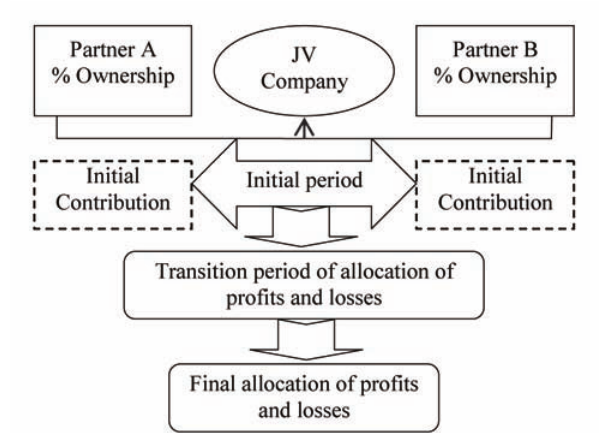
Fig. 1. The process of compensation and allocation of profit and losses in joint ventures (Juan et al.